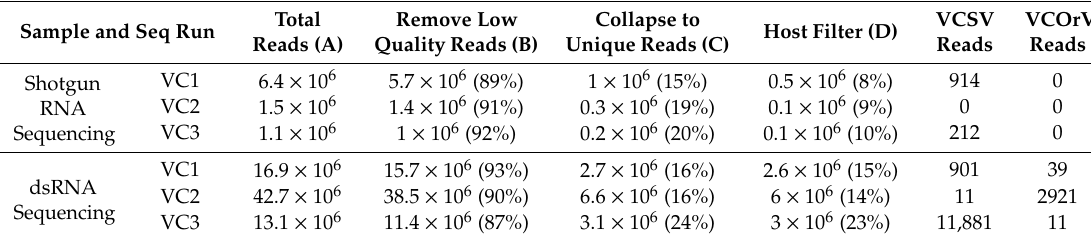
Table 1. Summary of sequencing depth and aligning reads to veiled chameleon serpentovirus (VCSV) and veiled chameleon orthoreovirus (VCOrV). The total number of sequences generated per sample. (A) Number of initial reads (single, shotgun RNA; paired, dsRNA). (B) Number of reads remaining after removing low-quality sequences. (C) Number of reads remaining after collapsing non-unique sequences into a single read. (D) Number of reads remaining after removing host-derived sequences. The total number of reads aligning to VCSVs and VCOrV are included.